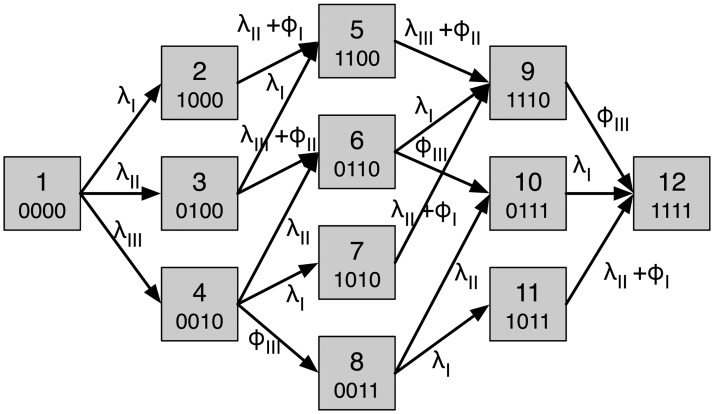
The state transition diagram for the tongue cancer model.Each node corresponds to a possible metastatic state and is represented by a binary string which signifies which lymph node station is positive or negative. For convenience the nodes are named from 1 to 12. The rates are obtained from the flow rates in the anatomic network (Fig 1) by considering the rate at which individual sites become positive based on the state of the other sites.